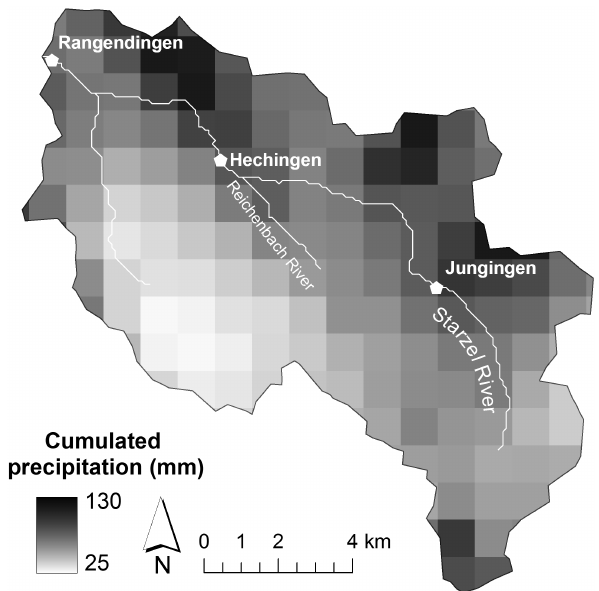
Fig. 5. Event-cumulated rainfall spatial distribution over the Starzel catchment at Rangendingen.